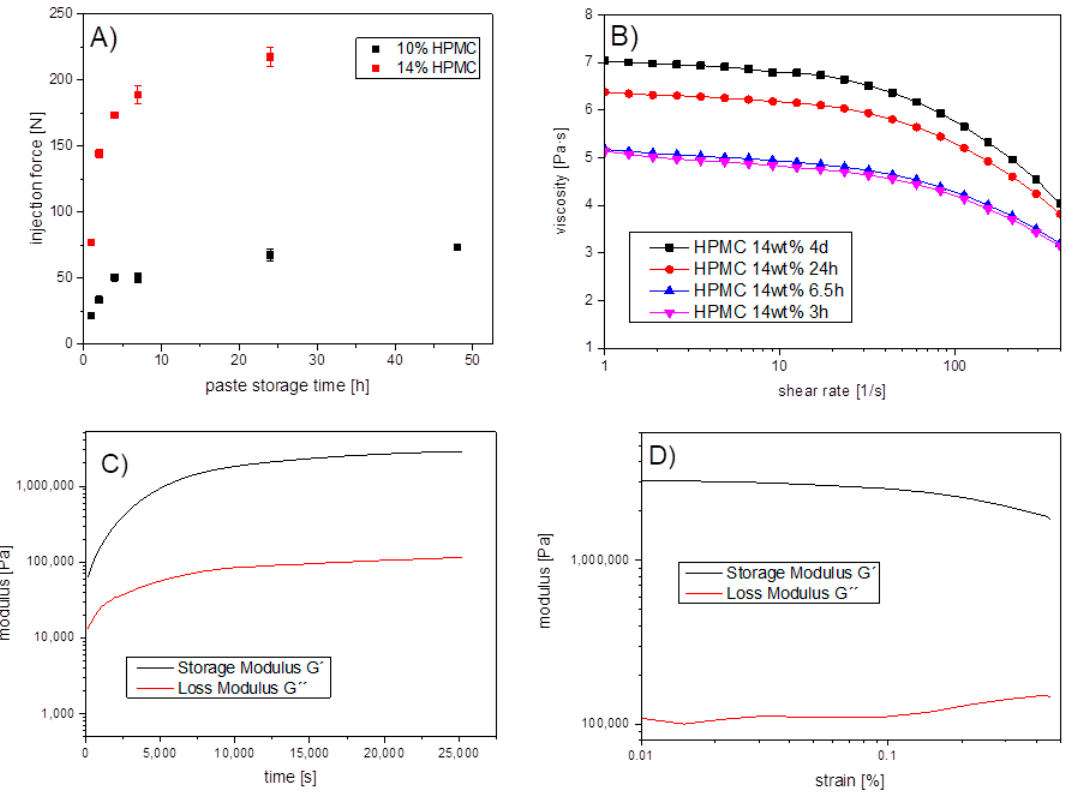
Figure 1. Rheological properties of the fabricated cement pastes: ( A ) medium load for cement paste extrusion from a syringe with 18 G cannula depending on storage time of the pastes; ( B ) time-dependent viscosity of a HPMC solution in water without further cement additives; ( C ) storage- G ′ and loss modulus G ″ of a 10 wt% HPMC/magnesium phosphate paste in an oscillation regime over 7 h at a frequency of 10 1/s, an amplitude of 0.1% and a temperature of 21.3 °C; ( D ) amplitude sweep of the paste at an amplitude of 0.1% and a temperature of 21.3 °C after 7 h oscillation.